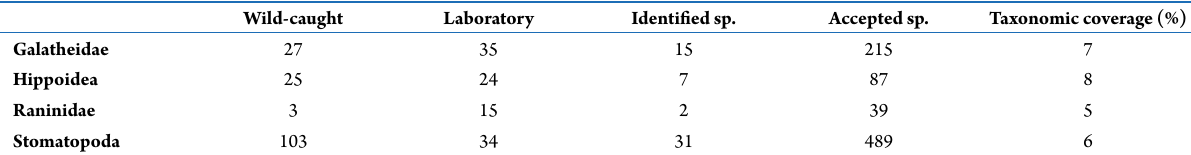
Table 1. Group composition (wild-caught and laboratory specimens given in numbers) as well as number of species identified in the data set. Current number of accepted species of the group (WoRMS Editorial Board, 2021) and the resulting taxonomic coverage of the group by our data in